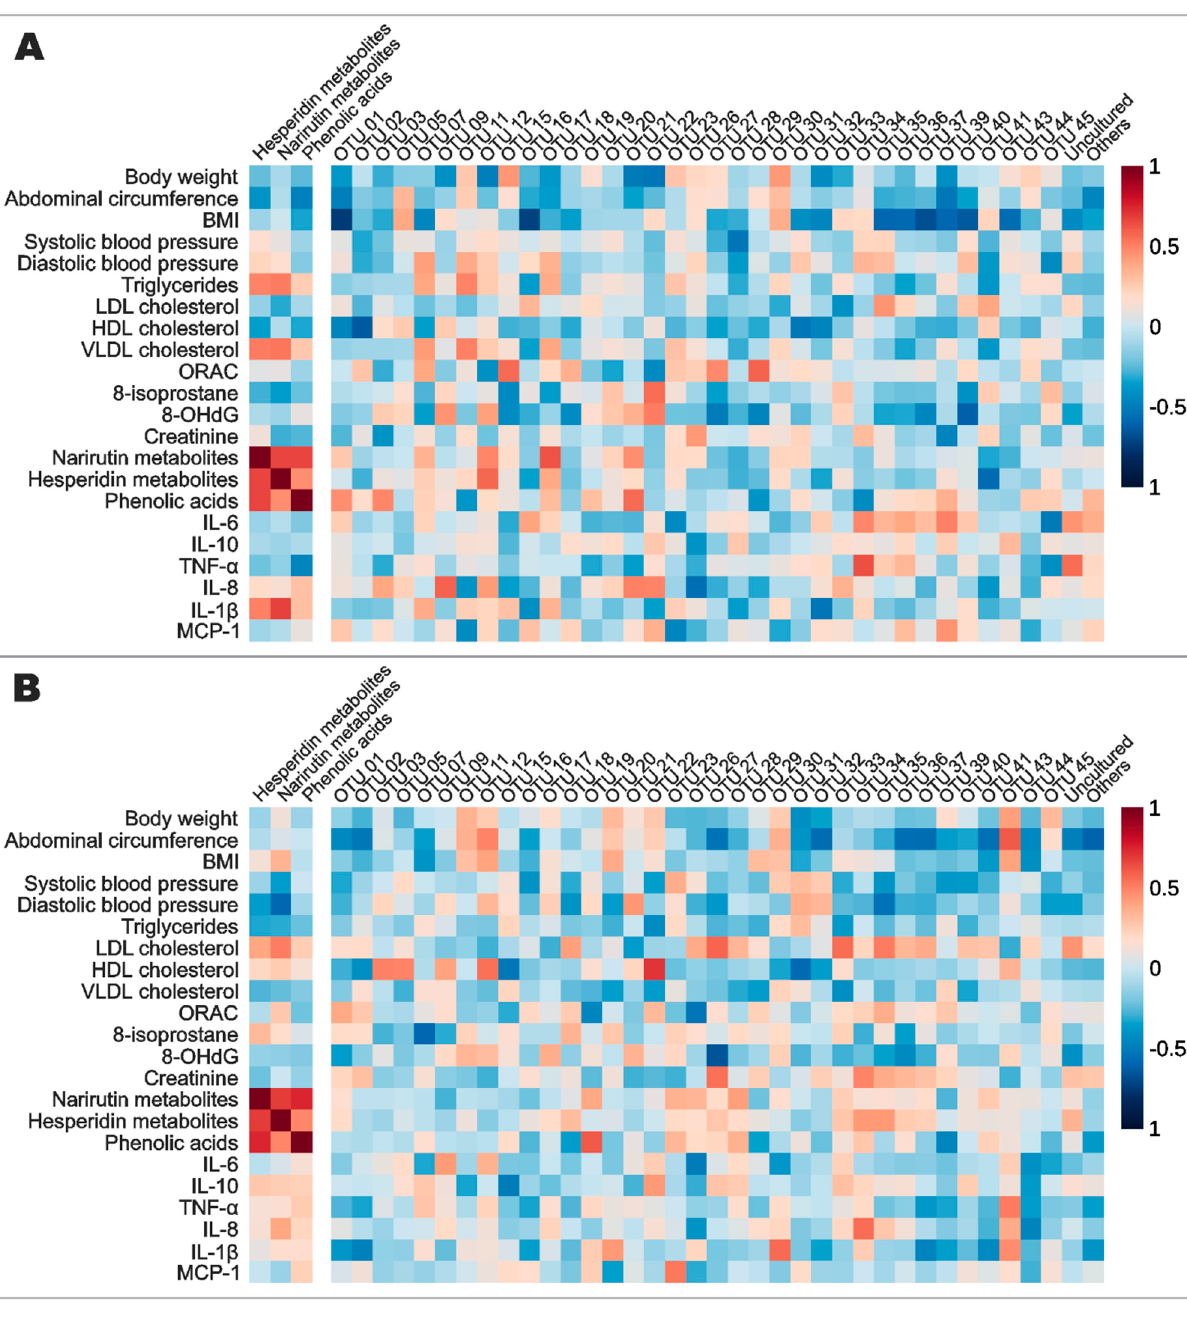
Figure 4. Spearman's correlation among excreted flavanone metabolites, most abundant genera in the gut microbiota, anthropometric variables, biochemical parameters, and inflammatory and oxidative stress biomarkers analyzed before and after the intake of Pera ( A ) and Moro ( B ) orange juices. 8-OHdG: 8-hydroxy-2'-deoxyguanosine; BMI: body mass index; HDL: high-density lipoprotein; IL: interleukin; LDL: low-density lipoprotein; MCP-1: monocyte chemoattractant protein-1; ORAC: oxygen radical absorbance capacity; OTU: operational taxonomic unit; TNF- α : tumor necrosis factor alpha; VLDL: very-low-density lipoprotein. OTU IDs are from Table S11.